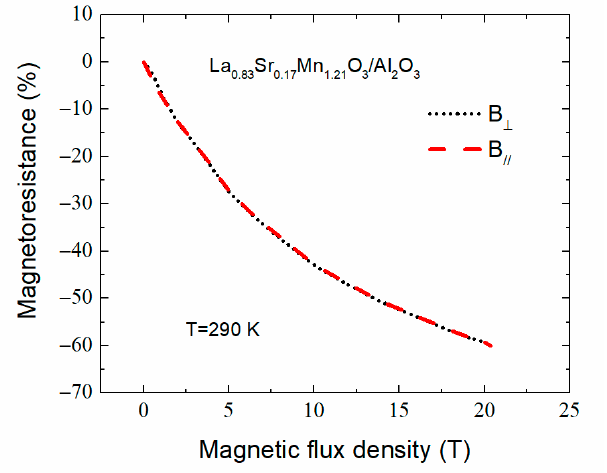
Figure 14. Magnetoresistance of La 0 . 83 Sr 0 . 17 Mn 1 . 21 O 3 film deposited on Al 2 O 3 substrate vs. magnetic induction in high magnetic field at 290 K temperature.